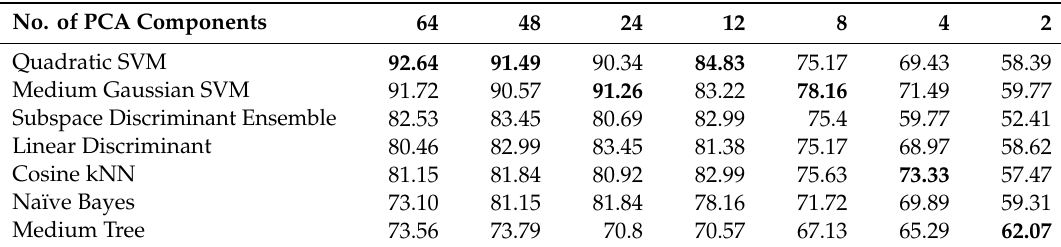
Table 3. Comparison of accuracy percentage for a various number of principal components. Maximum accuracies marked in bold font